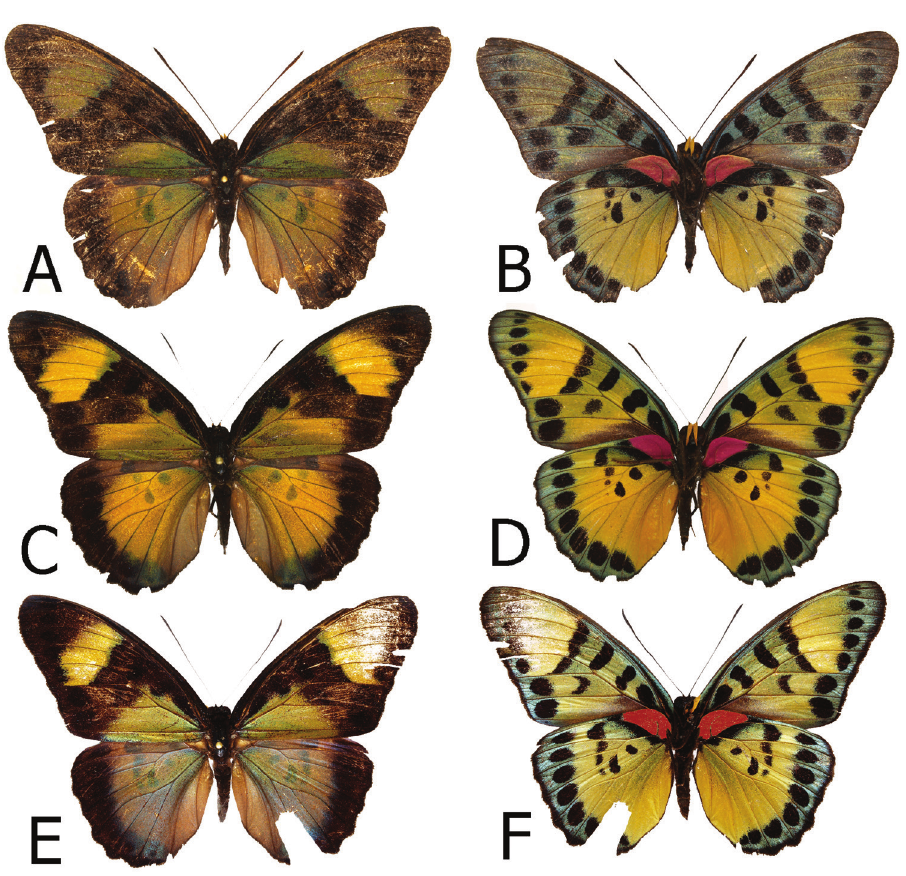
Figure 3. Adults, females: A E. cyparissa cyparissa Guma, Sierra Leone (dorsum) B E. cyparissa cyparissa Guma, Sierra Leone (venter) C E. cyparissa nimbina Mont Nimba, Guinea, paratype (dorsum) D E. cyparissa nimbina Mont Nimba,Guinea, paratype (venter) e E. cyparissa aurantina Atewa Forest, paratype (dorsum) F E. cyparissa aurantina Atewa Forest, paratype